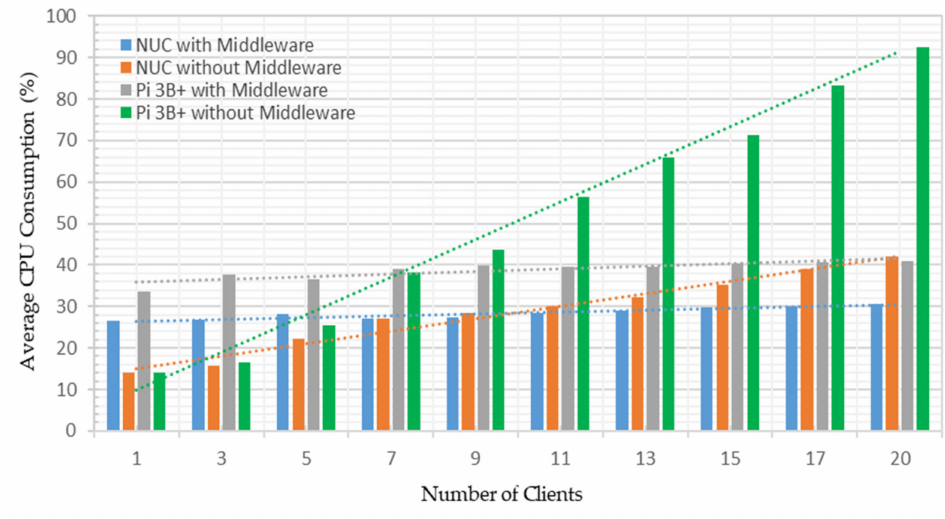
Figure 21. Average percentage of platform CPU utilized with varying